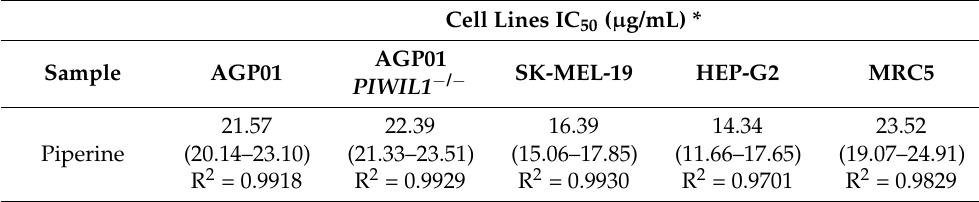
Table 2. Cytotoxic activity of piperine in cell lines after 72 h of